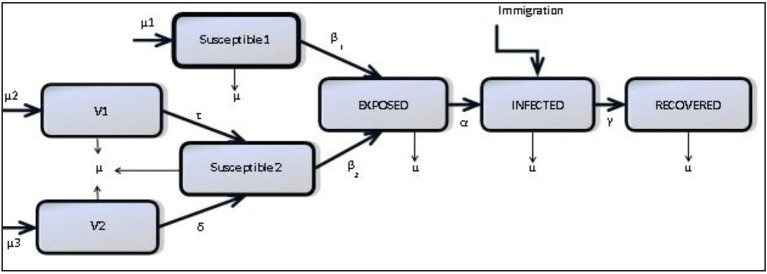
Mumps structure.